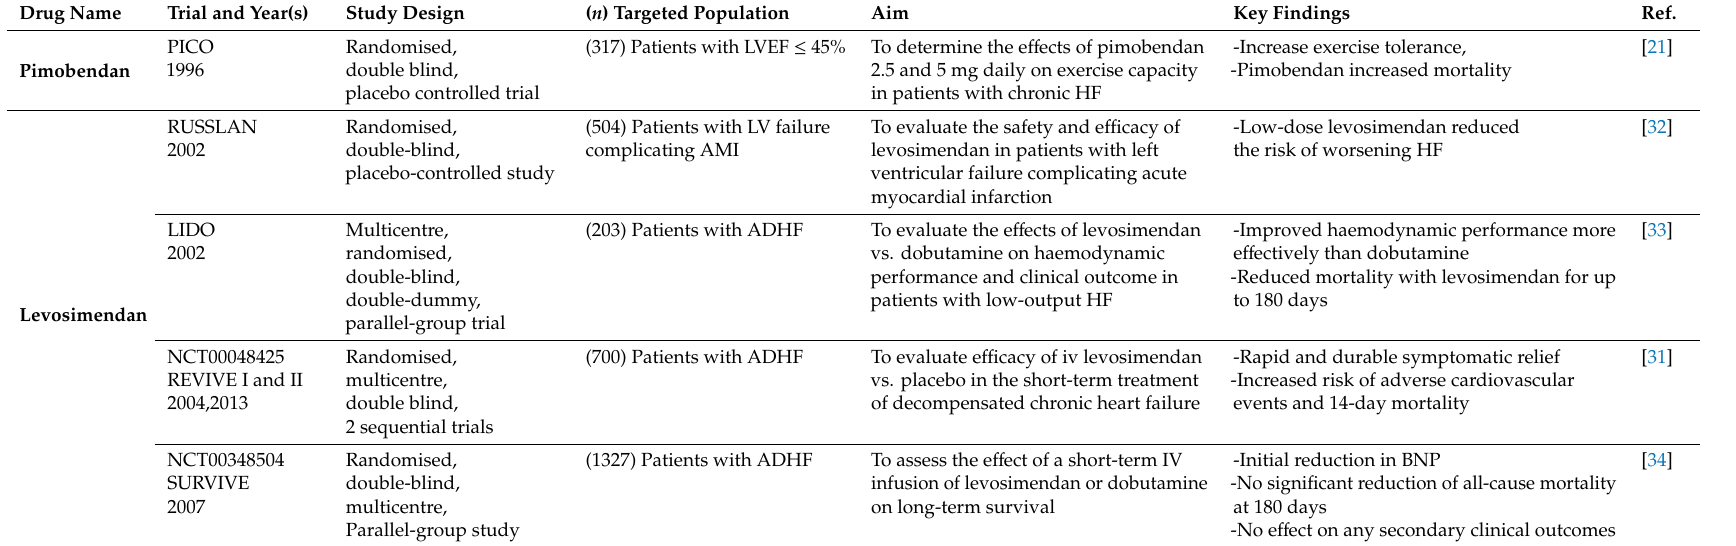
Table 1. Overview of reported clinical trials on calcium